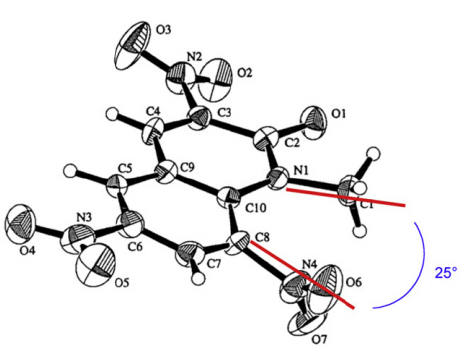
Figure 4. ORTEP (30% probability ellipsoids) view of trinitroquinolone 16 .